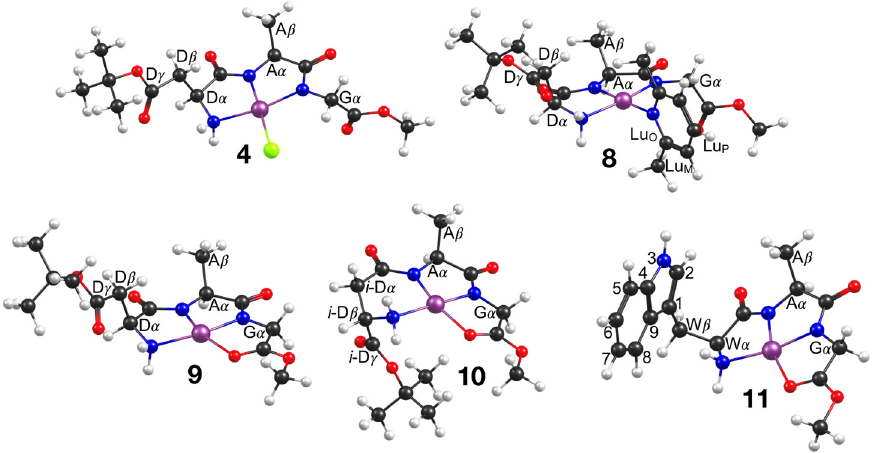
Figure 4. DFT-optimized structures of Pd(II) complexes 4 , 8 – 11 .